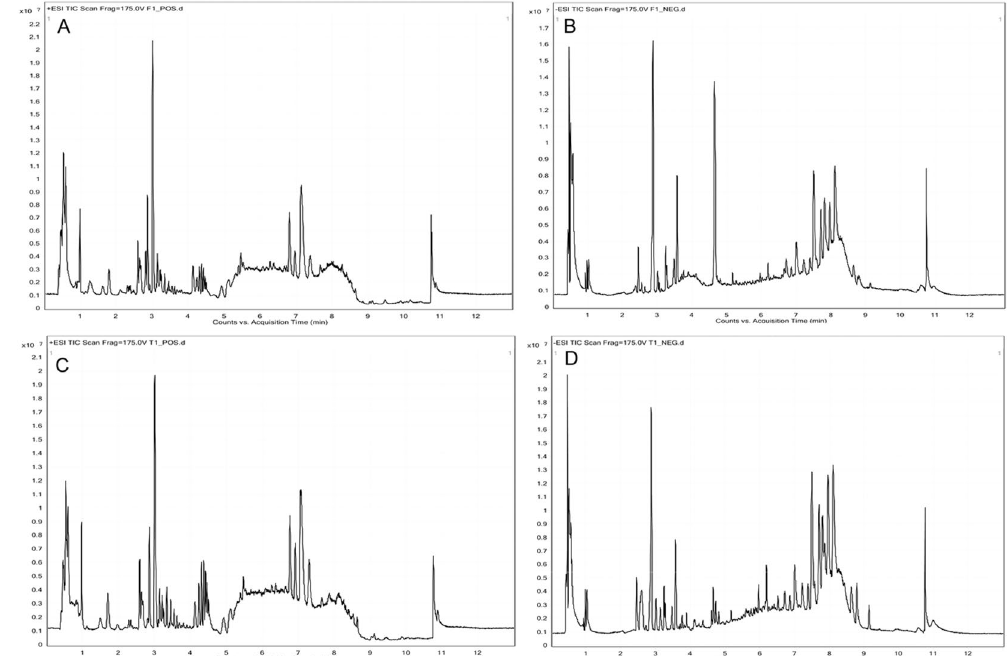
Figure 1. Typical TICs of metabolic profiles of early-stage NSCLC patients ( A ) positive ion mode; ( B ) negative ion mode and HC ( C ) positive ion mode; ( D ) negative ion mode based on UHPLC-Q-TOF/MS